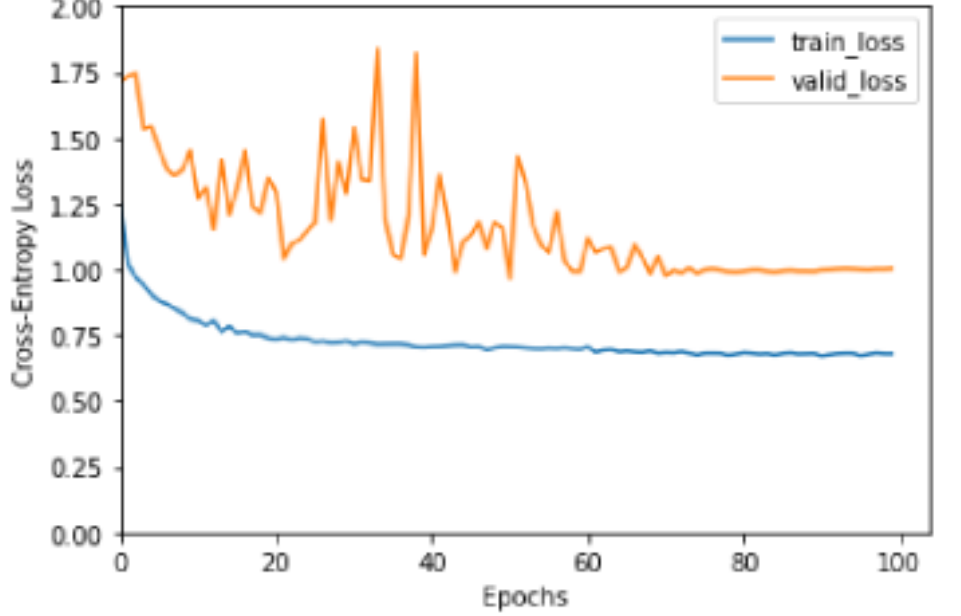
Figure 1. Illustration of the changes of the loss function value over the training and validation sets.